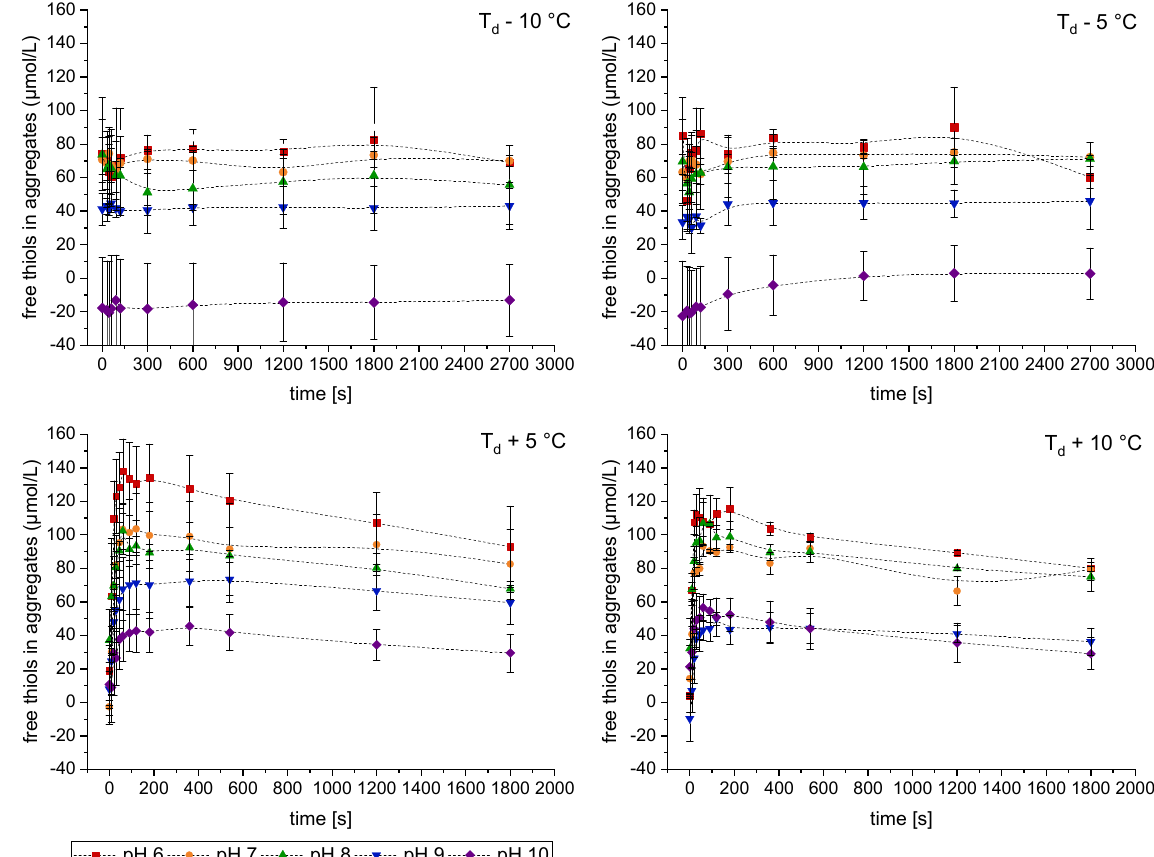
Figure 7. Amount of free thiol groups in the aggregate fraction during heating of a PPI solution in dependence of temperature and pH. Error bars represent the range of two independent heating trials.